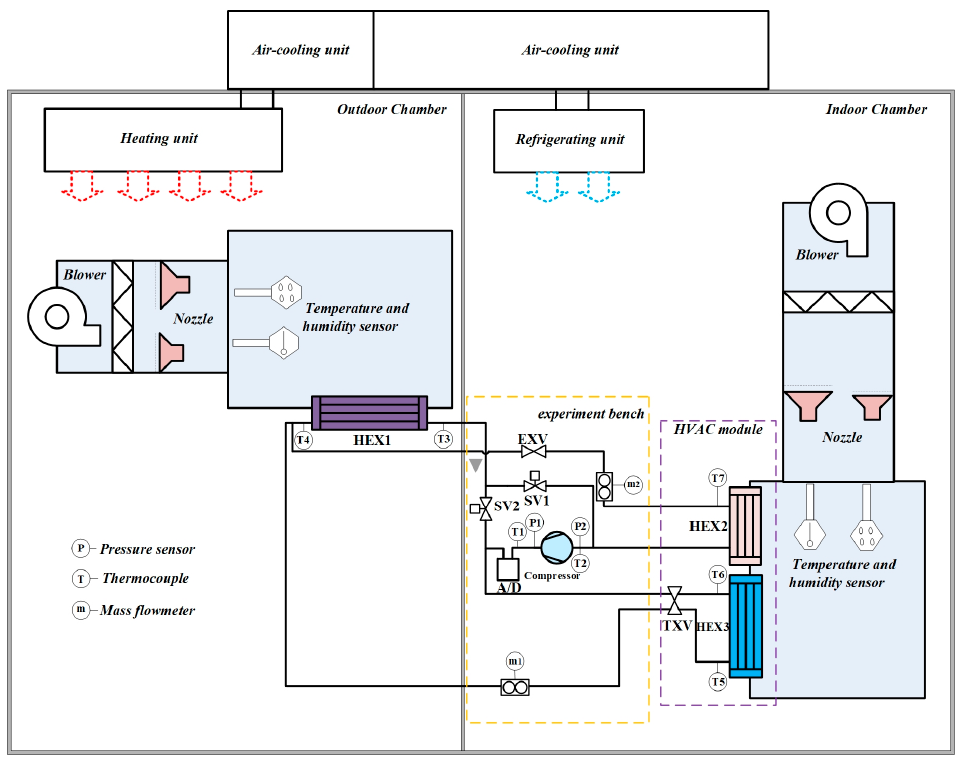
Figure 3. Experimental system layout in the laboratory.